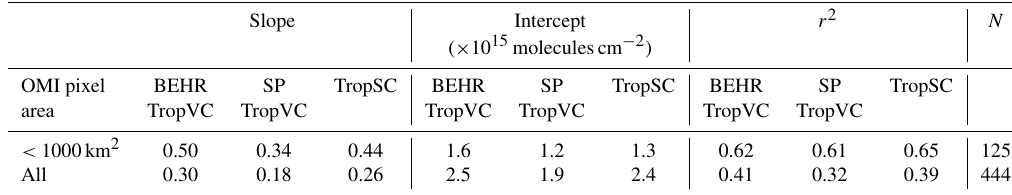
Table 4. Statistics between Pandora and OMI BEHR and SP TropVC and TropSC based on OMI pixel area.